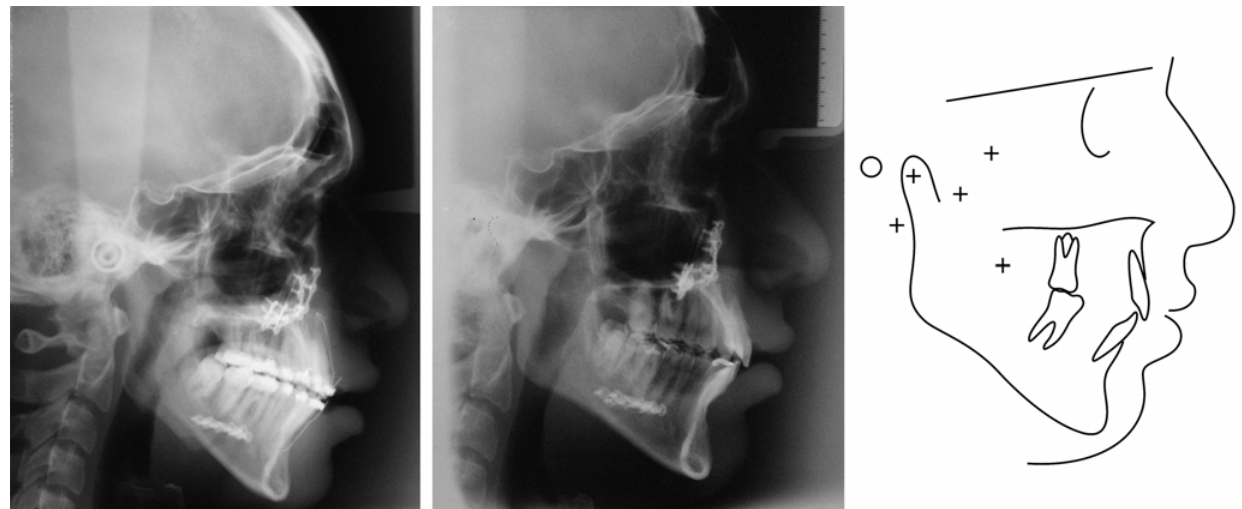
FIGURE 7- A- Headfilm immediately after surgery. B- Posttreatment headfilm and cephalogram